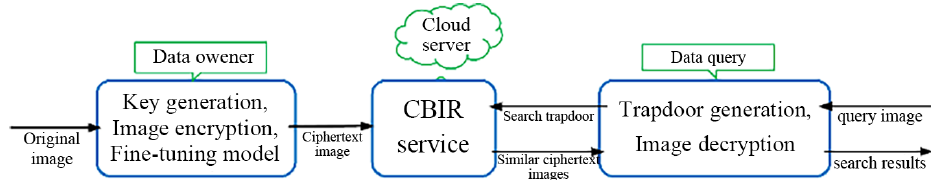
Figure 2. The details of our